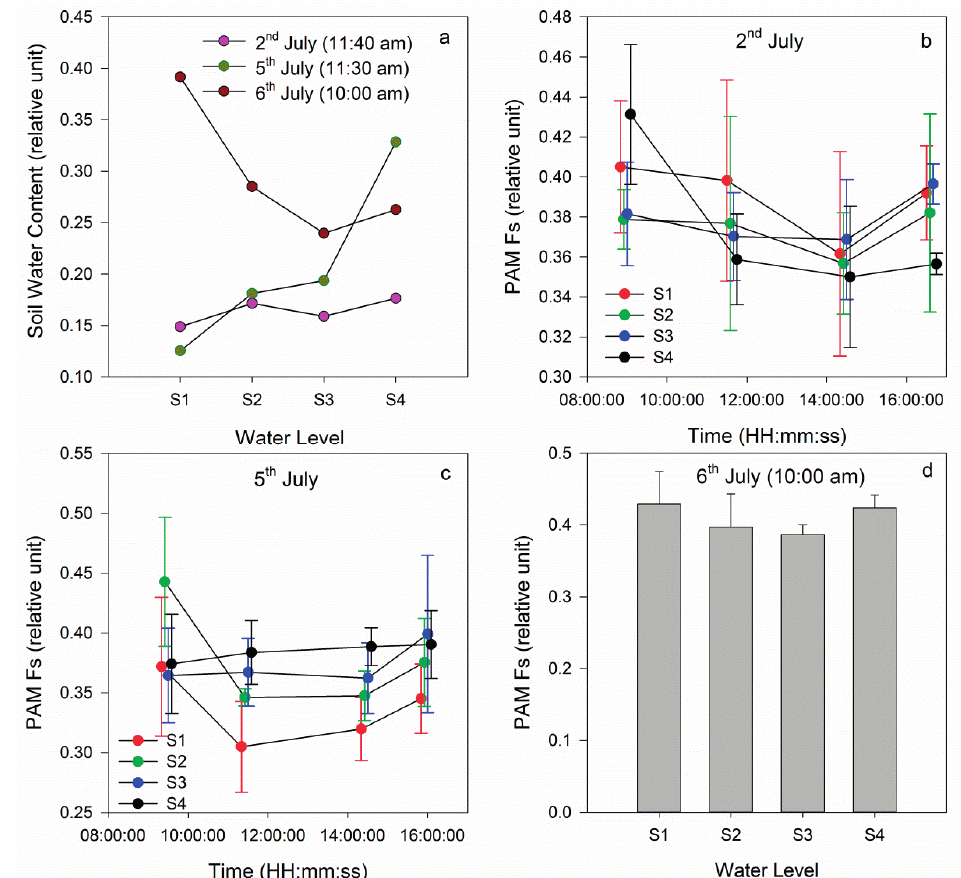
Figure 3. ( a ) Comparison of the soil water content; ( b ) Daily variations in the PAM Fs on 2 July; ( c ) Daily variations of PAM Fs on 5 July; ( d ) PAM Fs for the four groups on 6